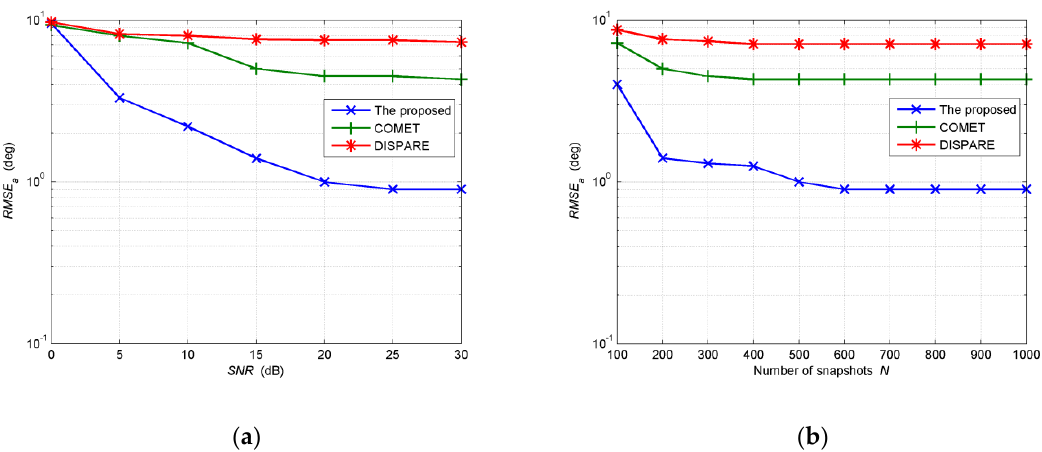
Figure 6. ( a ) RMSE a estimated by the three methods versus SNR; ( b ) RMSE a estimated by the three methods versus number of snapshots.